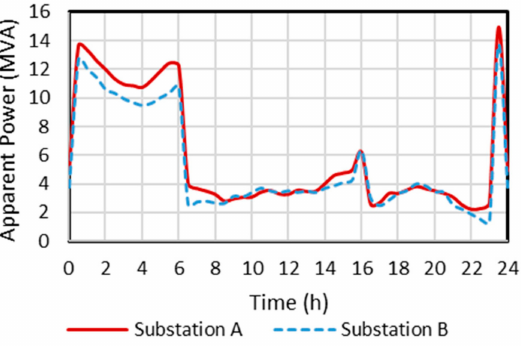
Figure 14. Apparent power flows through transformers after the introduction of DR scheme for scenario 5.